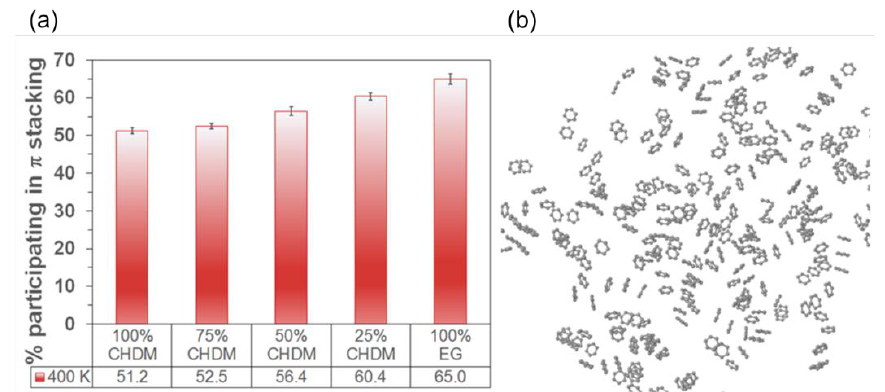
Figure 6. ( a ) Ratio change of aromatic rings participating in π stacking; ( b ) Rings forming π stacking for 100% CHDM case (adapted with permission from Reference [35], Copyright 2016 American Chemical Society).